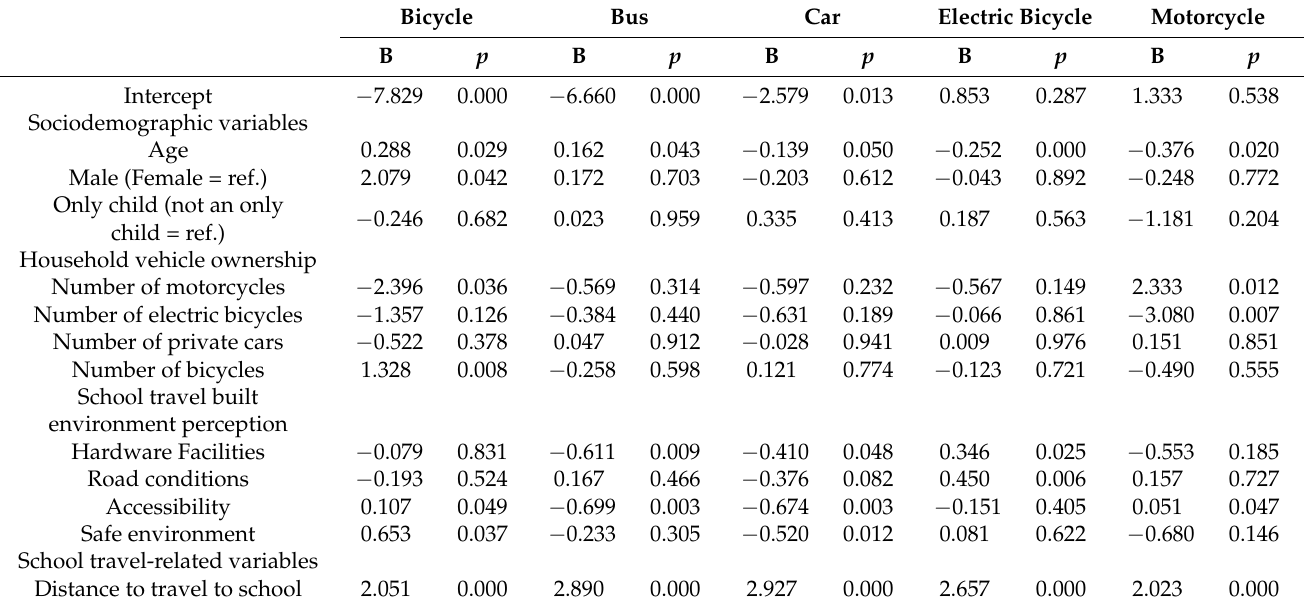
Table 10. MNL model parameter